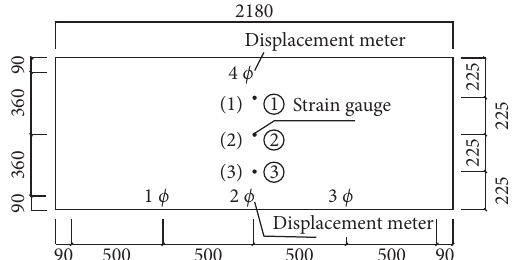
Figure 6: Plane arrangement of the strain gauges and the dis- placement